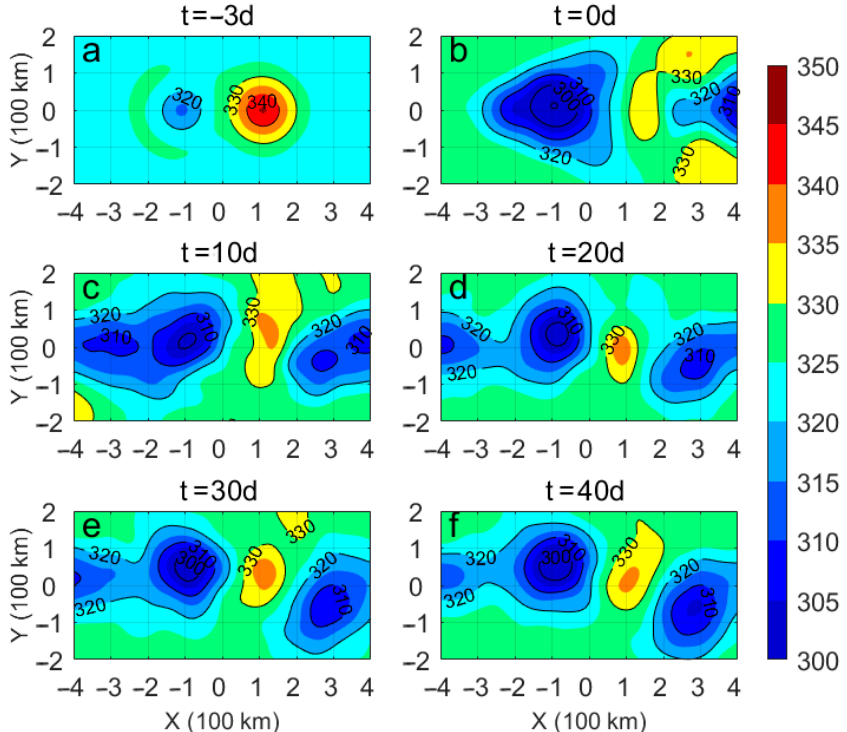
Figure 6. The temporal and spatial evolution of the depth of the 10 °C isotherm (D10) of the model dipole. ( a – f ) are simulated D10 (unit: m) at − 3, 0, 10, 20, 30, and 40 days after the TC, respectively. Cold (blue) colors represent the COEs, and warm (red) colors represent the AOEs. The contour interval is 10 m. The initial depth of background 10°C isotherm is at ~325 m. All the subgraphs are the numerical results filtered by a 1° × 1° lowpass spatial filter.